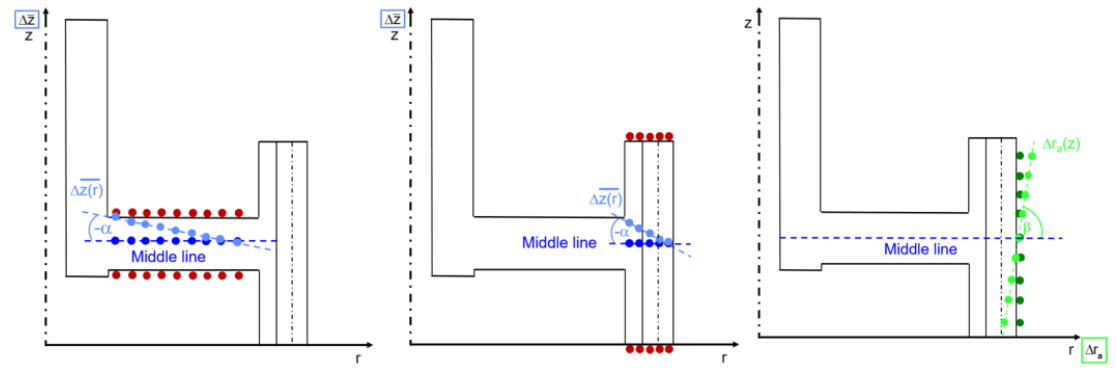
Figure 12. Calculation of the tilt angle at the web ( left ), gear rim ( middle ), and gear tooth ( right ). The simulated tilt angles of the gear tooth, gear rim, and web (if more than one measuring point was present in the area) are shown and compared with the experimental values in Figure 13. The simulation model calculated good results for all geometry types. Significantly, the simulation model correctly predicted the direction of the tilt. In detail, the gear tooth tilt angle calculated from the simulations lay within the error limit, except for geometry type G3. In the experiments, the change of z -coordinate at the web bottom was measured for only one component per type of geometry, and therefore, the calculation of standard deviations was not possible. However, the differences between the experimentally determined and calculated tilt angles were still